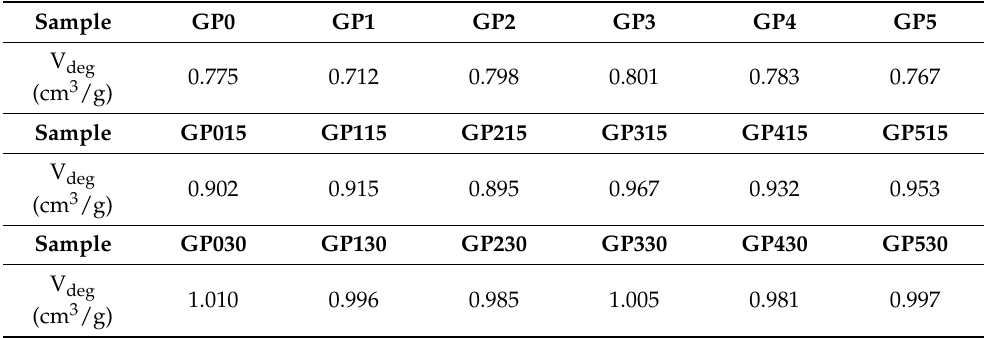
Table 11. Vacuum stability test results for the composite